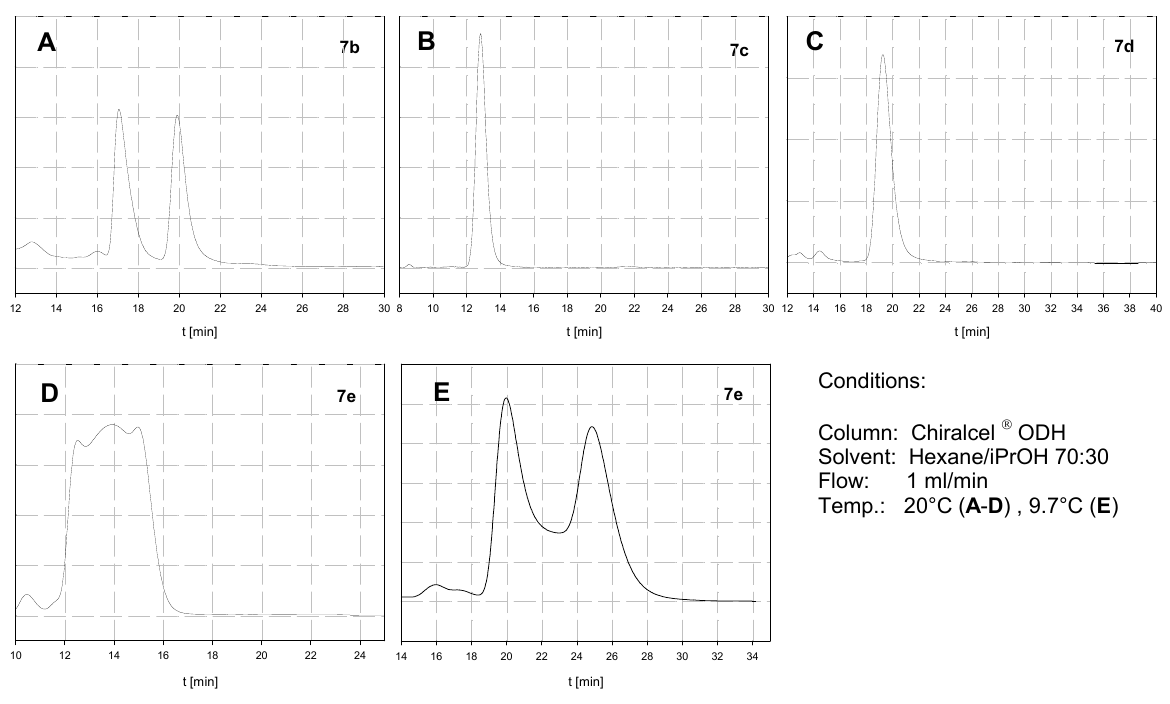
Figure 2. Chiral HPLC of 1,6-Naphthalenophanes 7b – e .